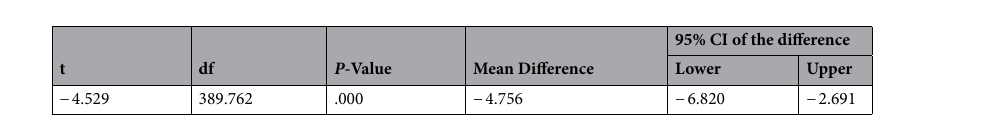
t df P -Value Mean Difference − 4.529 389.762 .000 − Table 2. The HQOL score before and after the challenge. DV: HQOL score / IV: before and after the walking challenge.